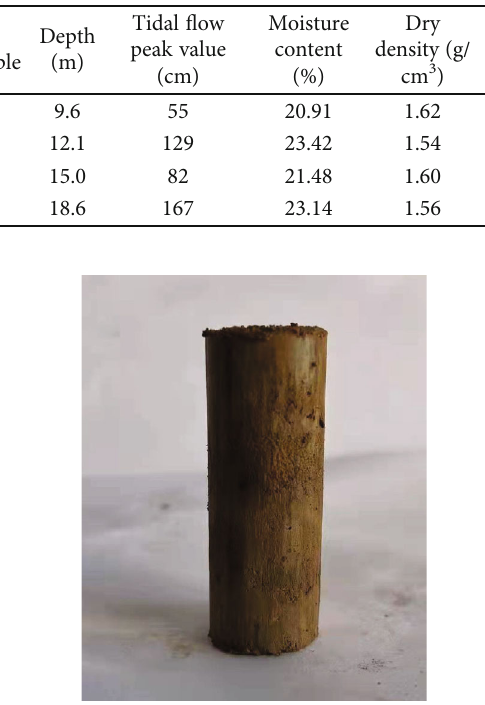
Table 1: Main physical parameters of clay layers.